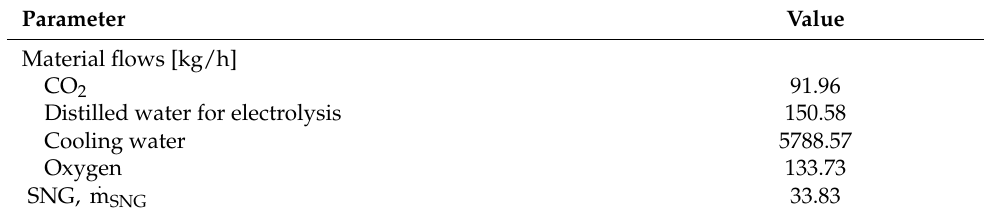
Table 8. PtSNG plant material flows, energy flows and performance parameters with a 1 MW el